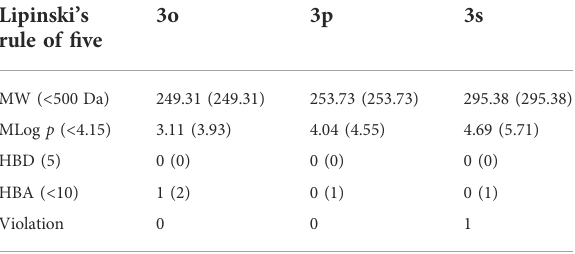
TABLE 2 The predicted druggability of compounds 3o, 3p, and 3s a,b